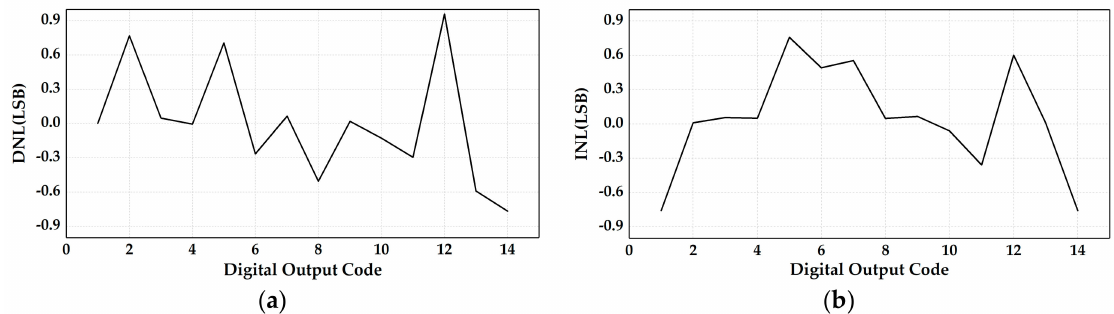
Figure 15. Measured ( a ) INL and ( b ) DNL performance before calibration.